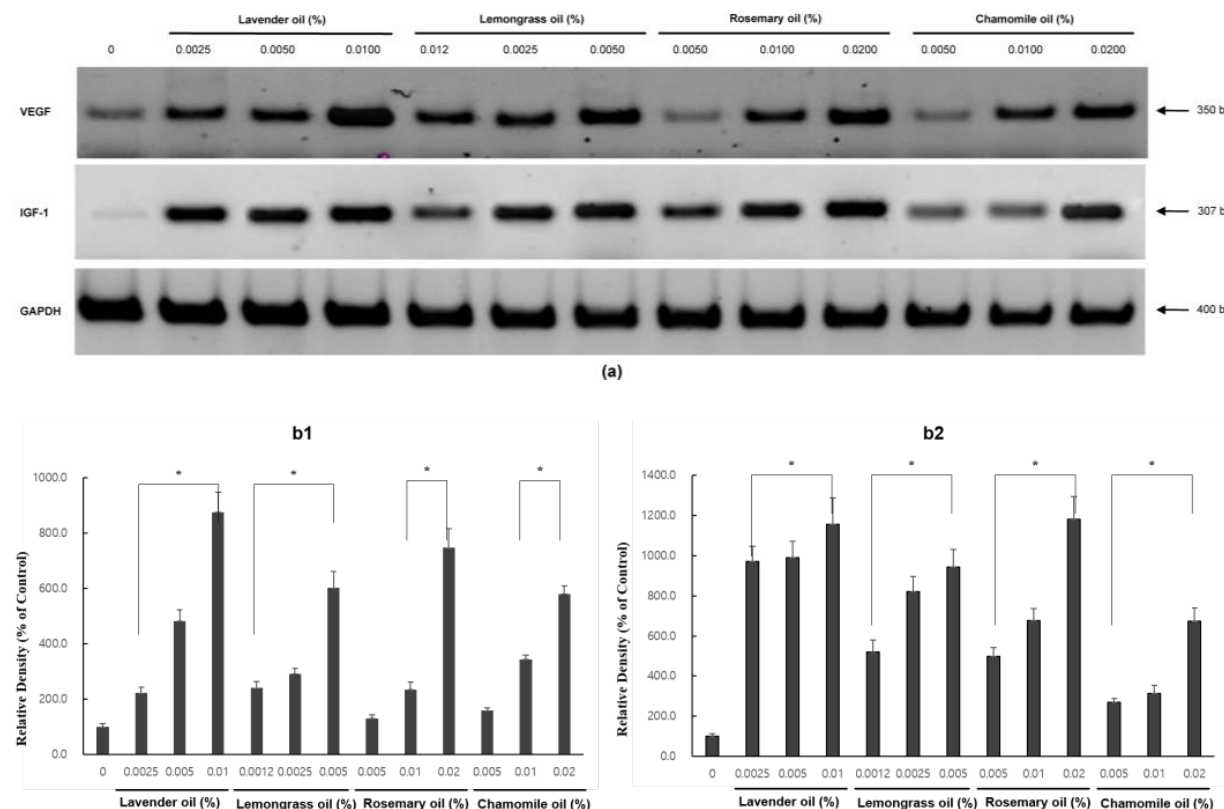
Figure 6. Dose-dependent induction of the mRNA expression of VEGF and IGF-1 in essential oils-treated DPC. ( a ) The DPCs were treated with lavender oil (0.025–0.01%), lemongrass oil (0.0012–0.005%), rosemary oil (0.005–0.02%), and chamomile oil (0.005–0.02%). The figure shows representa-